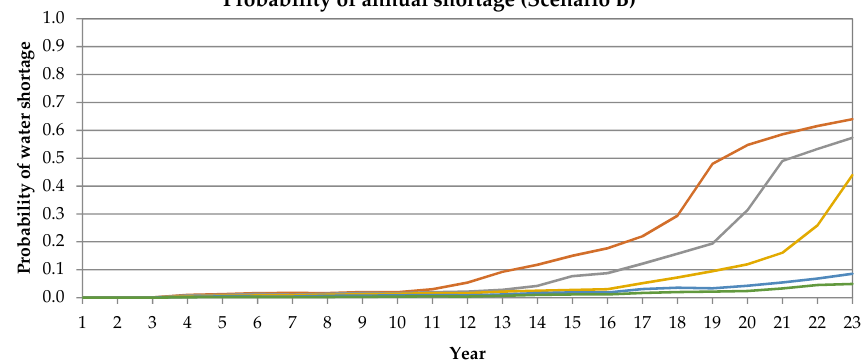
Figure 6. Expected probability of annual water shortages of different magnitudes in Great Gaborone for each year in Scenario B, including the Dikgatlhong Dam.